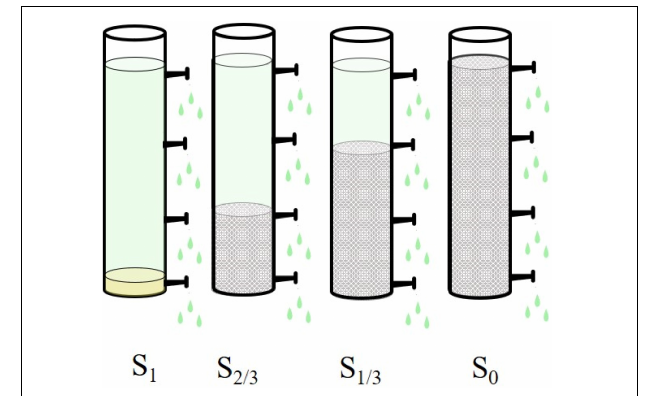
FIGURE 1 | Schematic diagram of the experimental